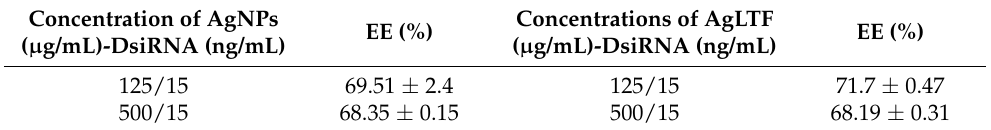
Table 2. EE of AgNP-DsiRNA and AgLTF-DsiRNA at various concentrations, n = 4. Concentration of